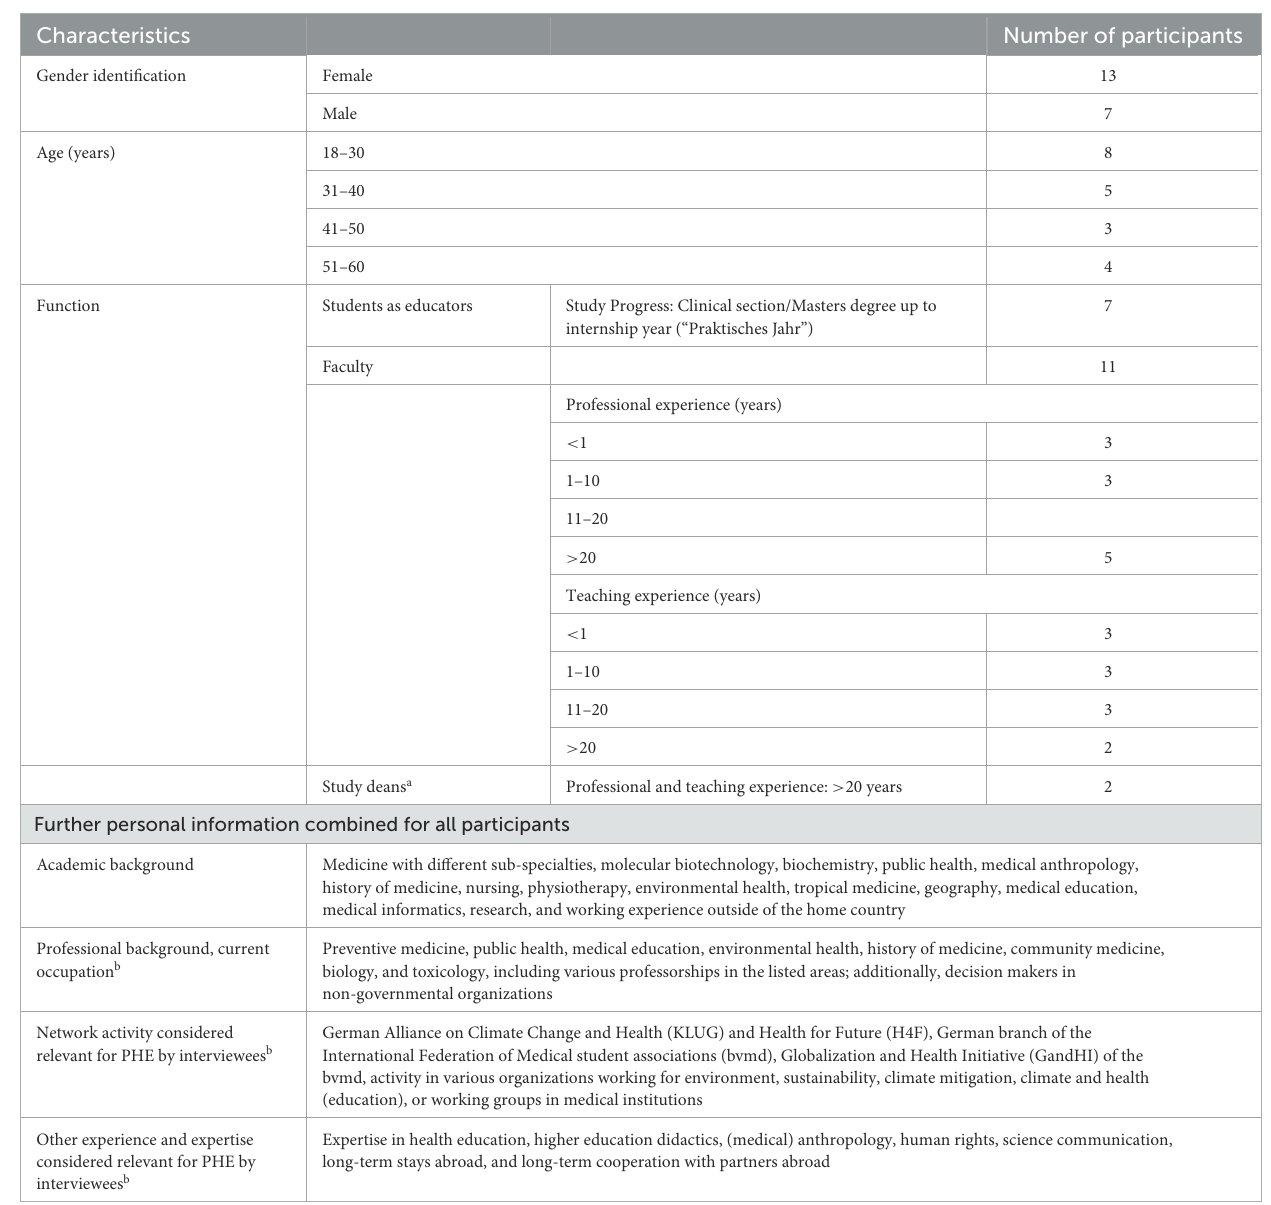
TABLE 1 Sociodemographic data of the participants.